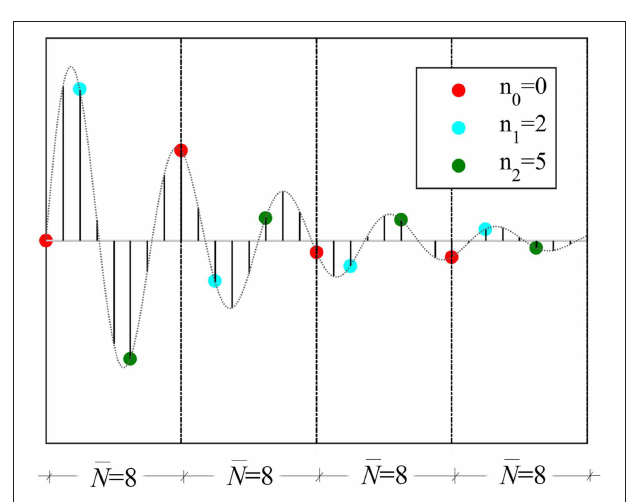
FIGURE 3 | Illustrative example of multi-coset